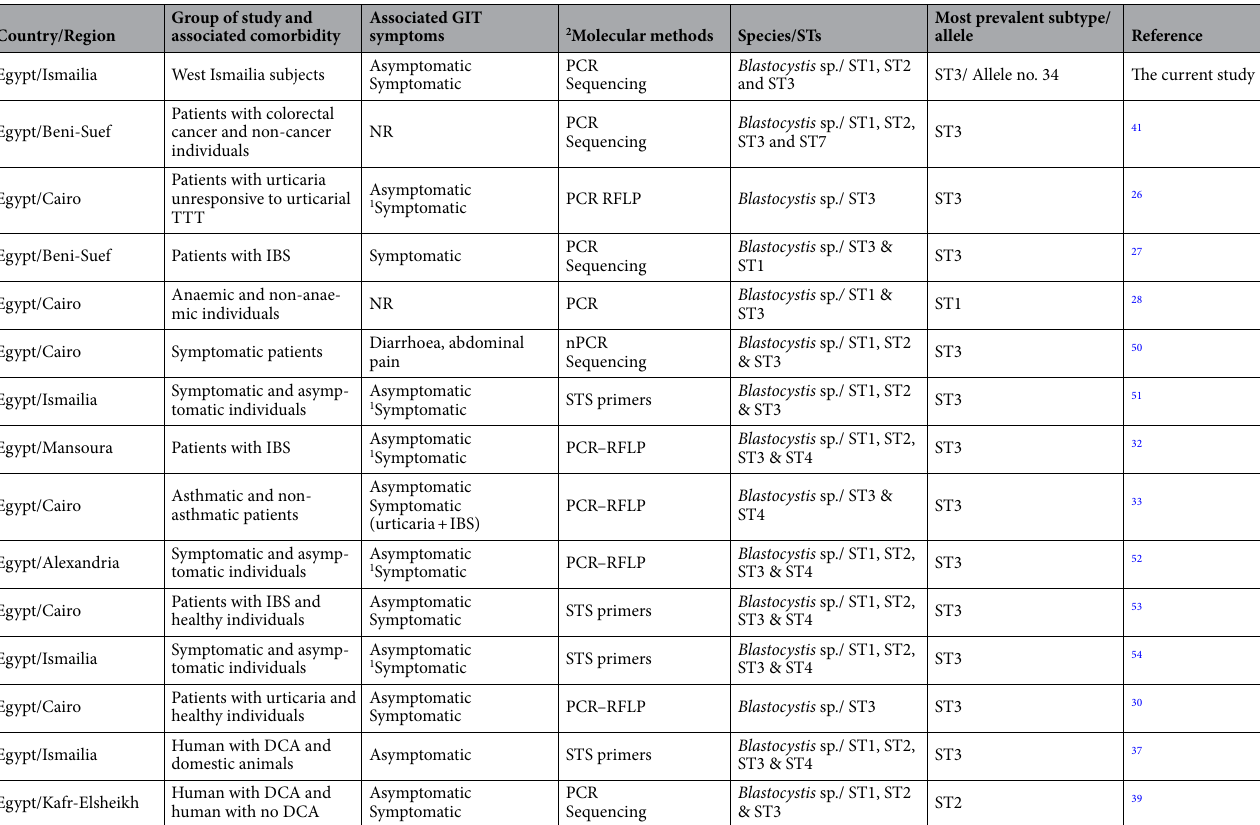
Table 6. Molecular genotyping data of Blastocystis sp. in the Egyptian population from several governorates. 1 Symptomatic cases have the following symptoms as a single presentation or in combination: diarrhea, abdominal pain, vomiting, flatulence, fatigue, and fever; 2 The target gene in all studies was small subunit rRNA; STS: sequence-tagged site primers; IBS: Irritable bowel syndrome; RFLP: Restriction fragment-length polymorphism; nPCR: nested polymerase chain reaction; NR: Not reported; sp.: Species; DCA: Direct contact with